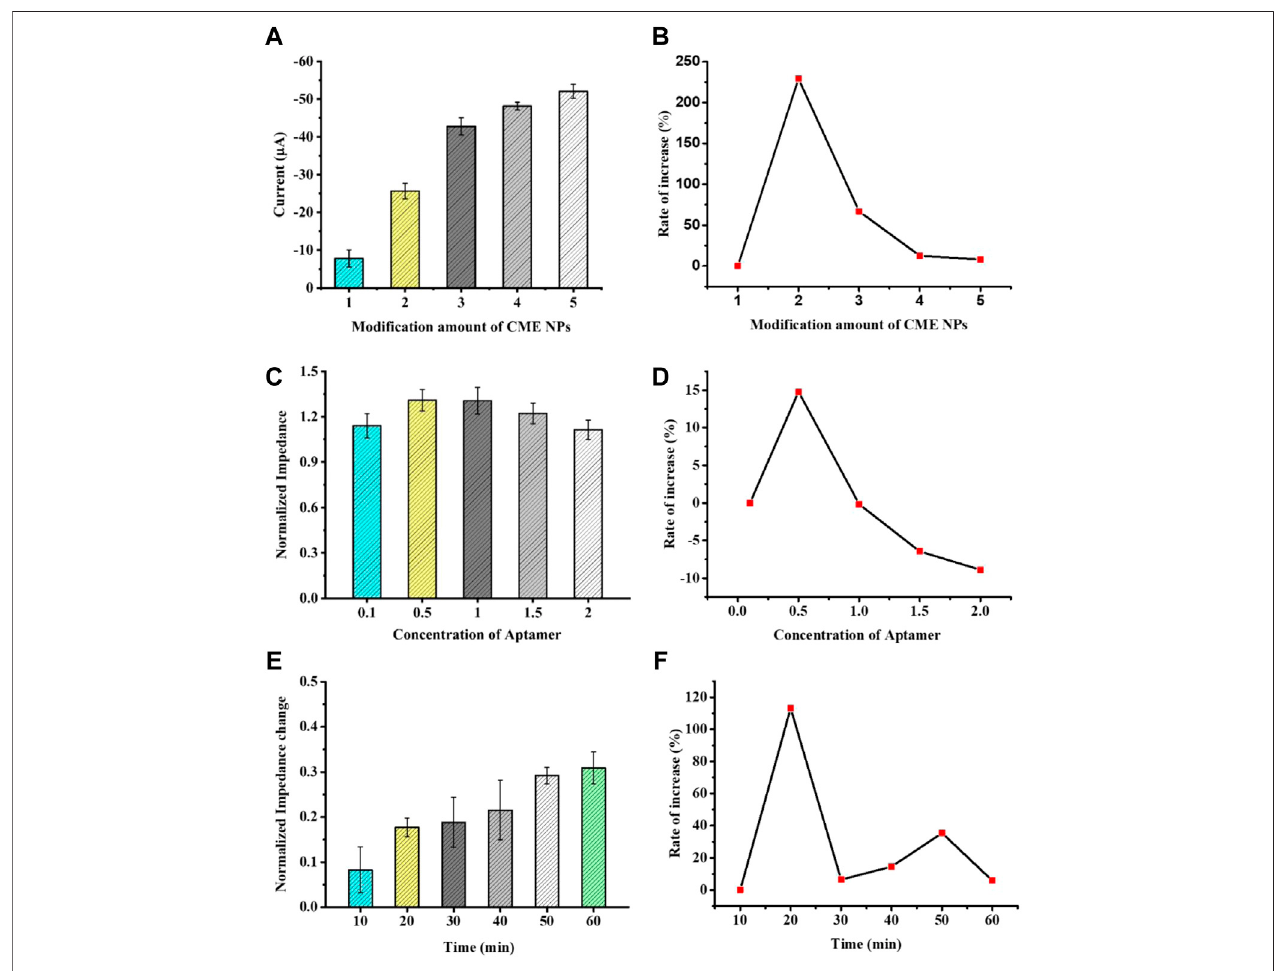
FIGURE3| Theoptimizationofexperimentalconditionswithmodi fi cationamountofCMENPs (A) ,concentrationofaptamer (C) ,andtimeofhybridization (E) .The rate of increase under certain conditions with CME NPs (B) , aptamer (D), and time of hybridization (F) . Error bars, SD, n = 3.